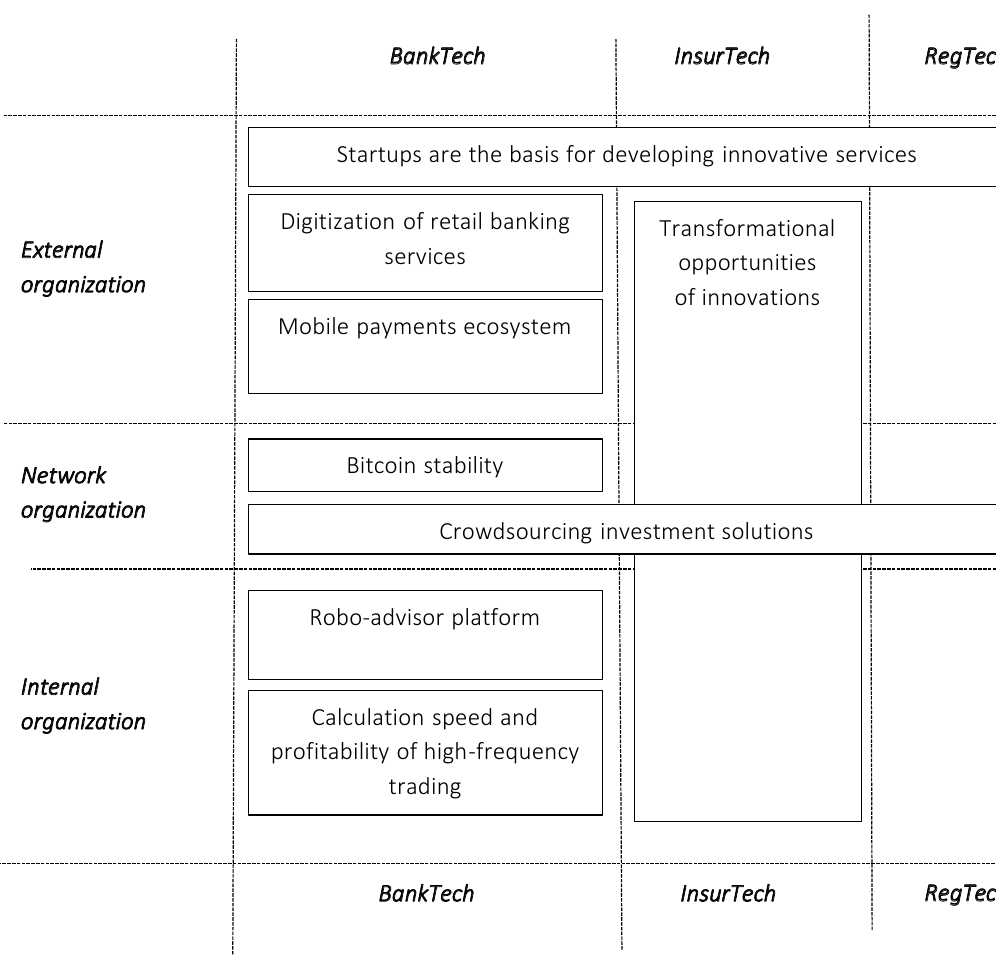
Figure 2. Matrix model of financial innovation